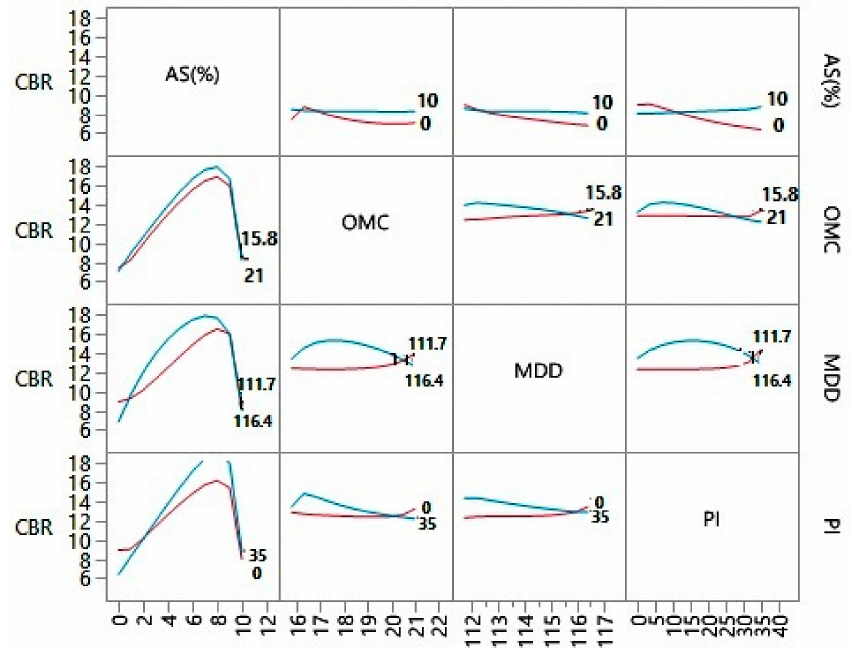
Figure 7. Interactional Profile Analysis for CBR.